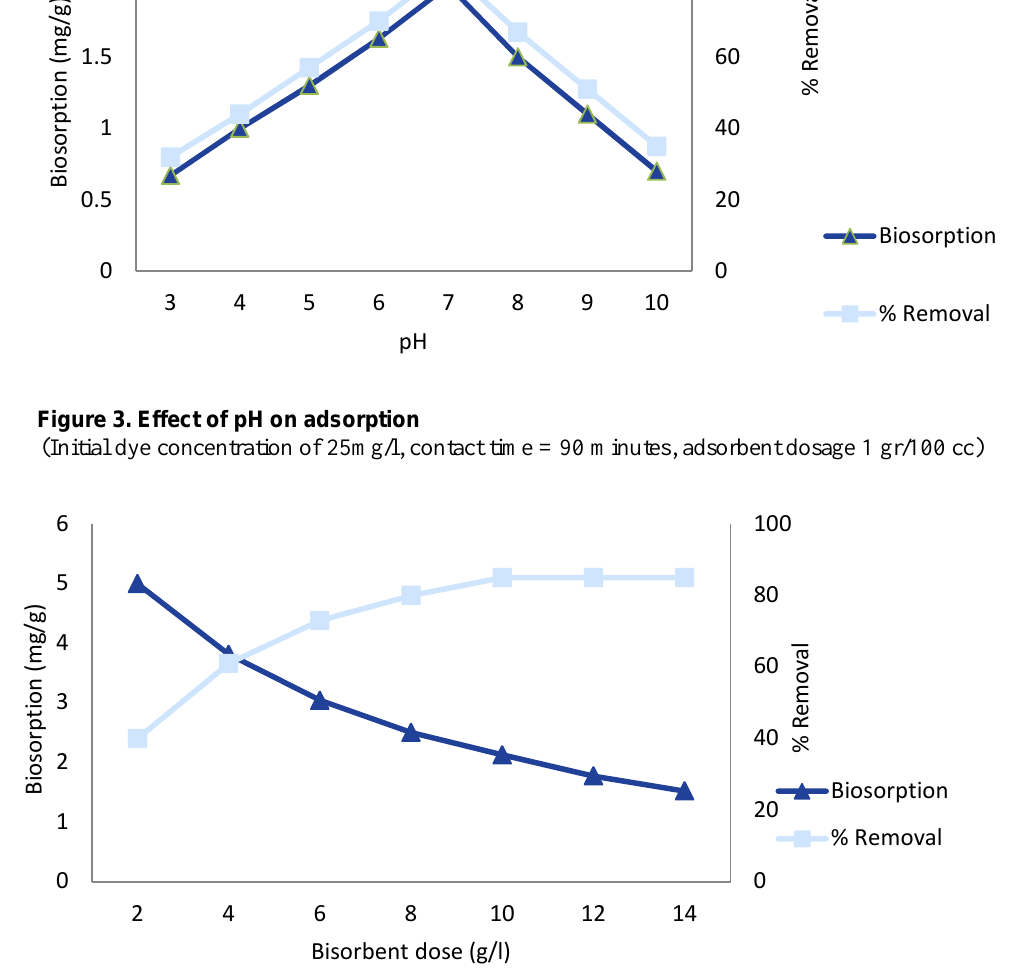
Figure 4. Effect of adsorbent dose on adsorption (Dye initial concentration 25mg/l, contact time = 90 min, pH =